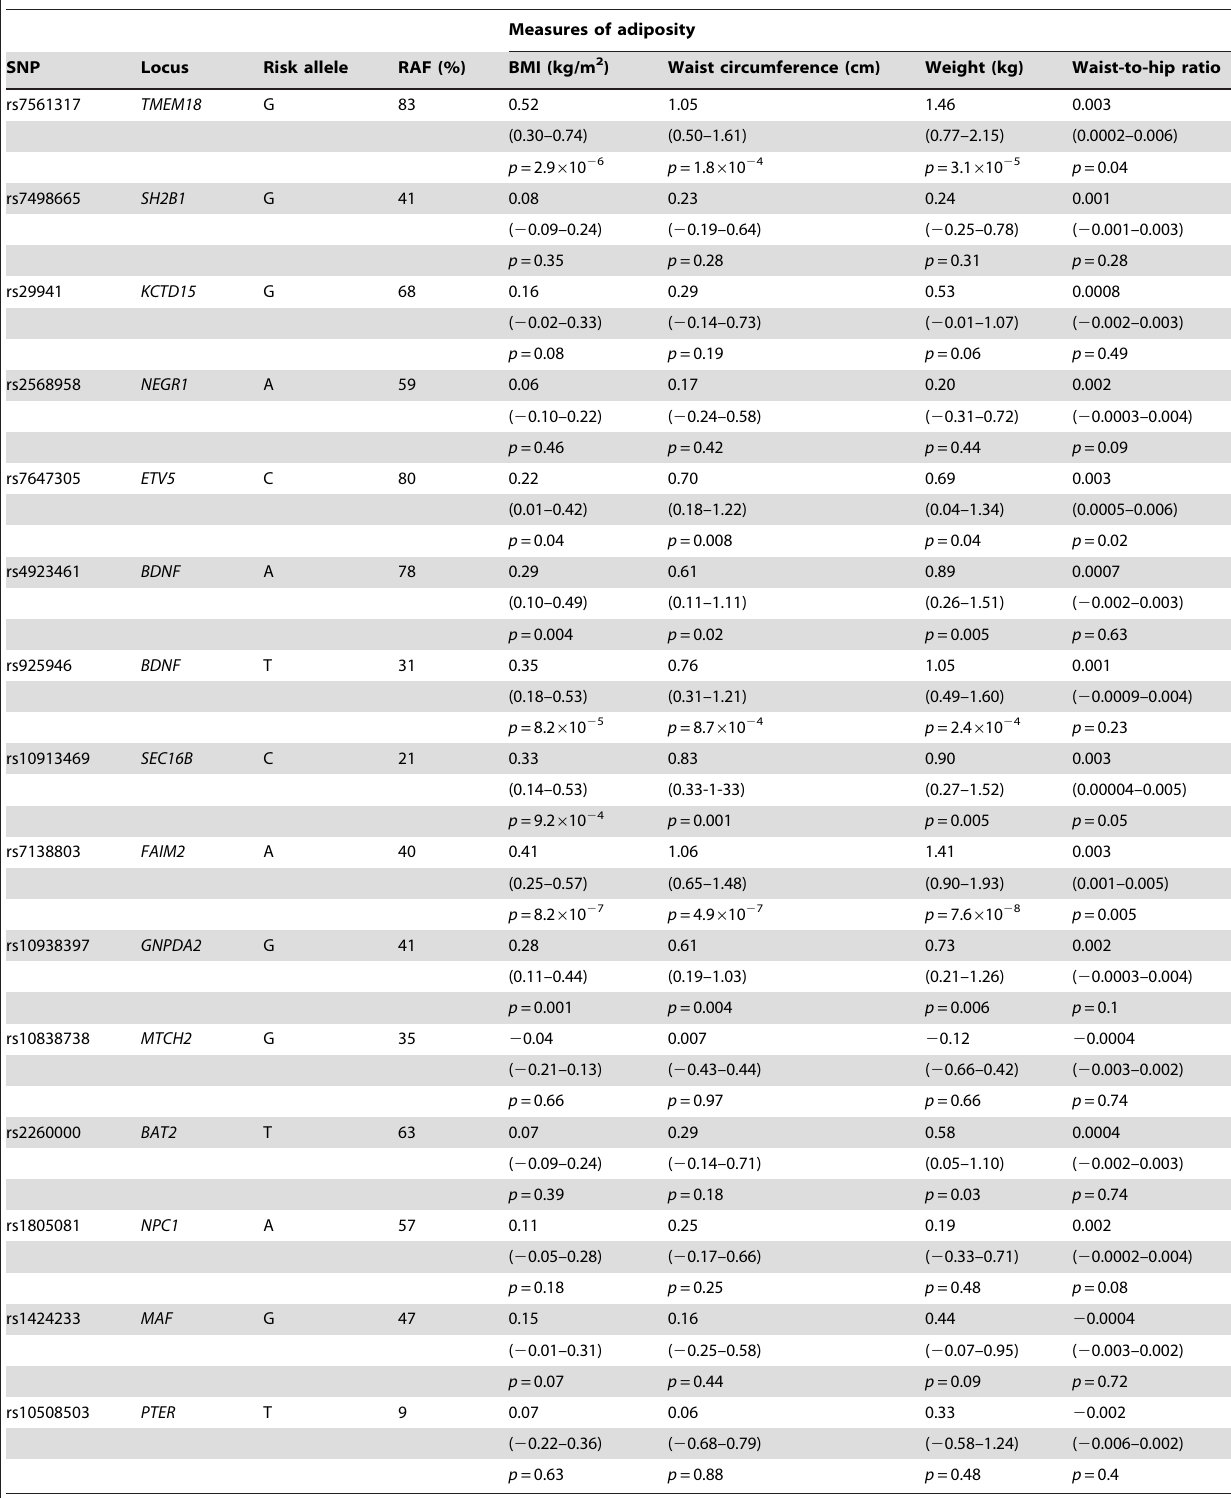
Table 2. Effects of and associations with the obesity risk alleles on measures of adiposity in the population-based Inter99 cohort.